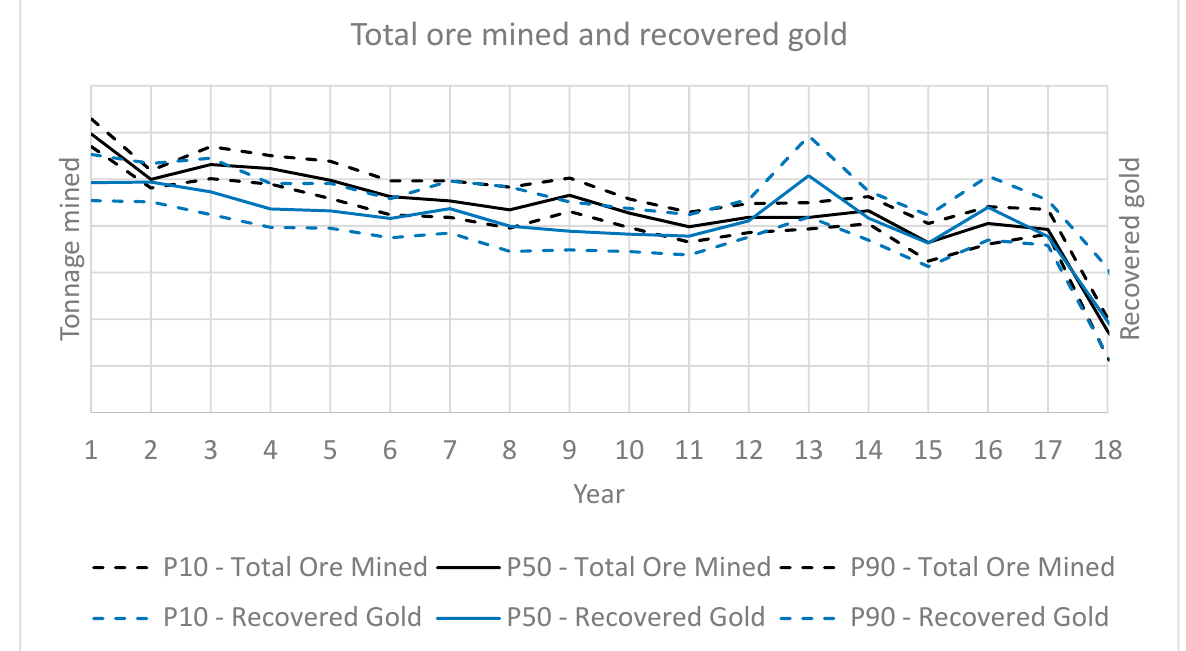
Figure 4. Total tonnage mined from the three mines at the RGM mining complex.